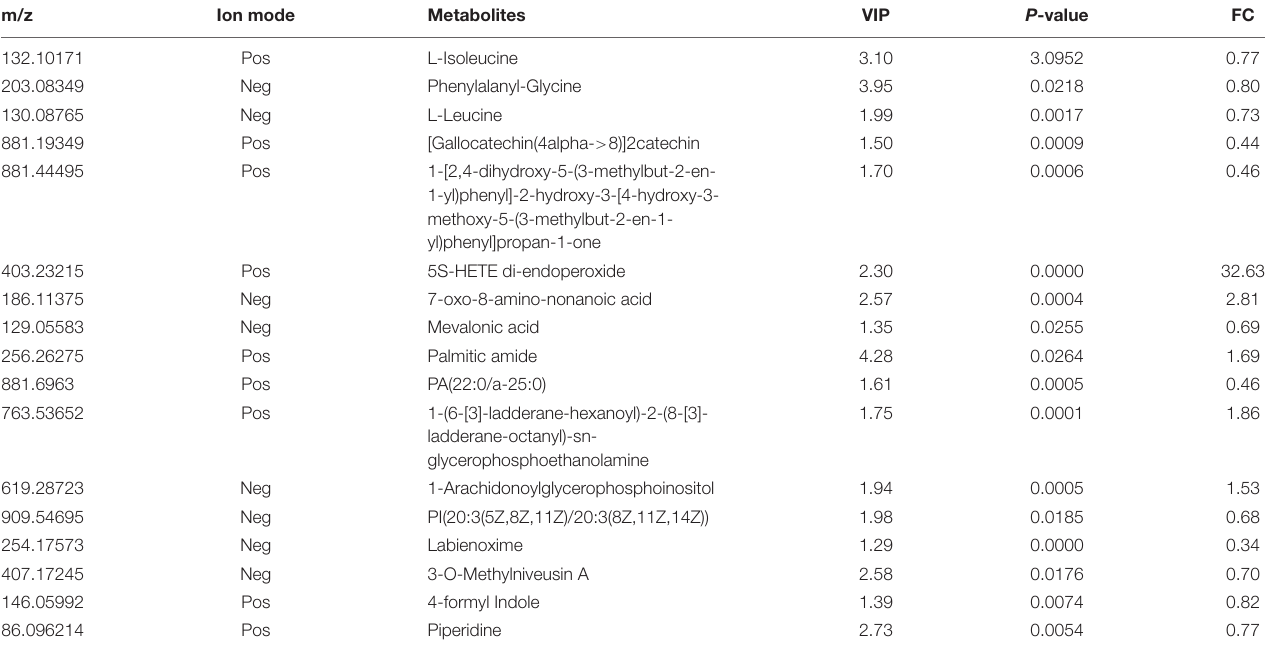
TABLE 2 | Summary of the differentially expressed metabolites between PHx and AR113 + PHx groups.